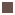
Thermal stability of inter-trimer chromophore interactions CD data.(A) Temperature-dependent Visible–CD spectra of WT in water, pH 6.5. (B) Representative spectra of 3Glu in 1 M KCl, pH 6.5. (C) Representative spectra of 3Glu in water, pH 6.5. (D) Plots of the ratio of the ellipticity at any temperature to that at 20°C, measured at 530 nm for WT(■), 3Glu (■) and 2Glu (■) in 1 M KCl and at 460 nm for 3Glu (■) in water, pH 6.5. The dotted lines represent the best fit of the experimental data, applying non-linear fit with single sigmoid Boltzmann function for 2Glu and 3Glu. The curve for WT shows bi-phase temperature dependence and was fitted to a sum of two sigmoid functions, applying the Boltzmann equation.